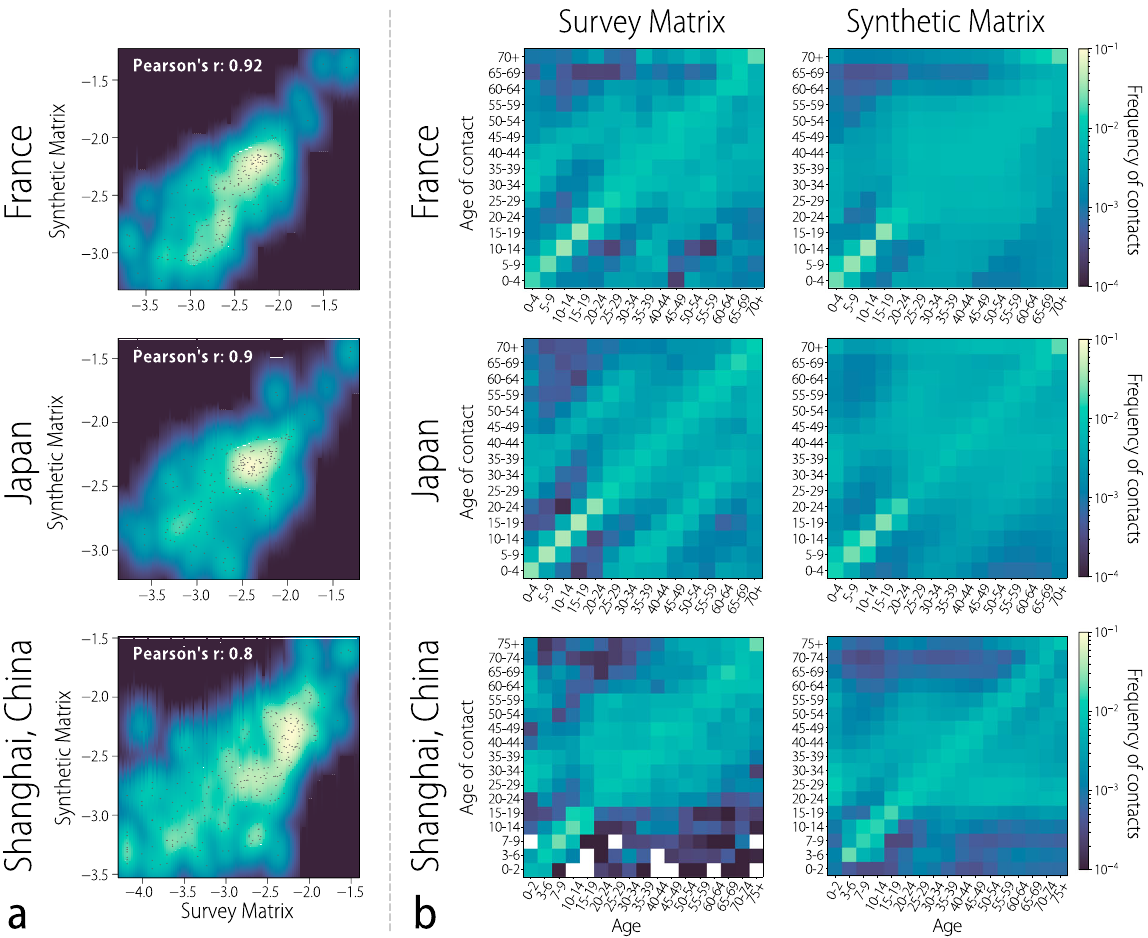
Fig. 3 Comparison to out-of-sample survey matrices. a Density plots showing the correlation of survey-based contact matrices for three out-of-sample locations (France, Japan, and the Shanghai Province of China) and their respective synthetic contact matrices (all normalized to sum to one). The points represent the actual values of the survey and synthetic contact matrices. The linear correlation between the elements of each survey matrix and the corresponding elements of the synthetic matrix is reported in terms of the Pearson correlation coef fi cient, whose values are reported in each plot. b Heatmaps representing the normalized survey matrices and the normalized overall synthetic matrices for France, Japan, and the Shanghai Province of